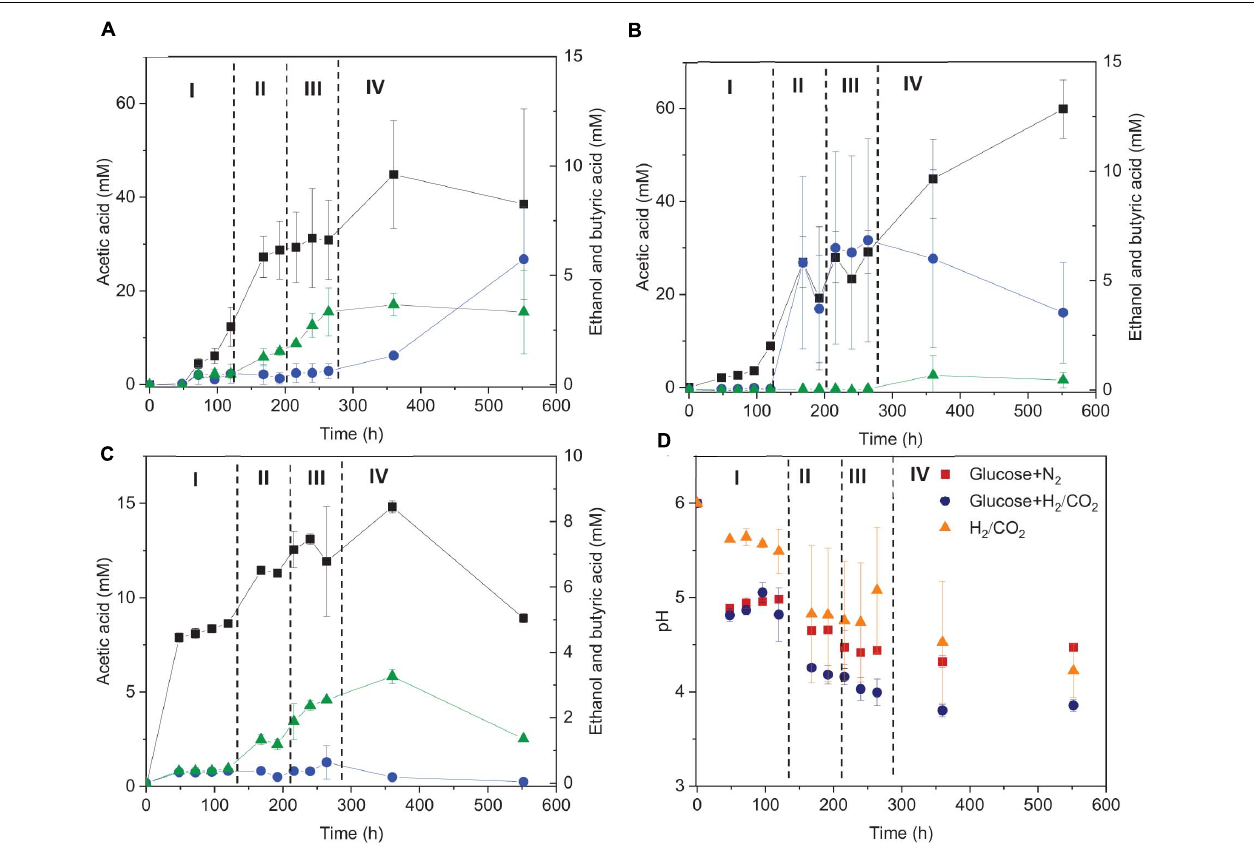
FIGURE 3 | Acetic acid, ethanol and butyric acid production by heated-treated granular sludge at 25 ◦ C using (A) glucose+H 2 /CO 2 , (B) H 2 /CO 2 , and (C) glucose as the substrate and (D) change of pH. The dashed vertical lines represent the different phases in the fermentation process; I: 0–120 h, II: 120–192 h, III: 192–264 h, IV: 264–552